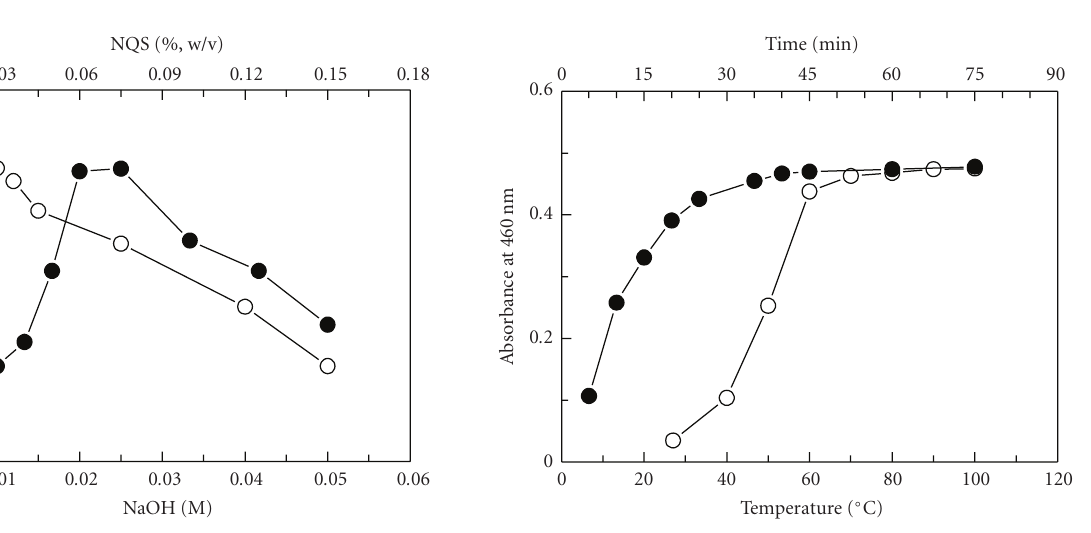
Figure 2: E ff ect of NaOH ( ◦ ) and NQS( • ) concentrations on the reaction of AMD (45 μ g mL − 1 ) with NQS.